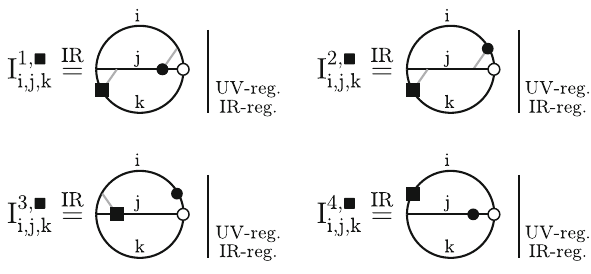
does not contain the integration and it is considered at the zero. The numbers i , j , k mean the type of the propagator, see Fig. 6